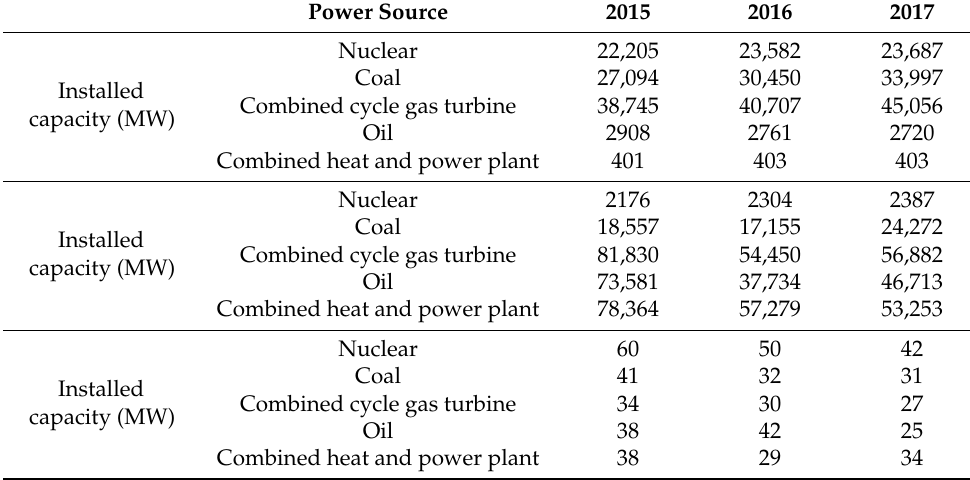
Table 2. Summary of the major power